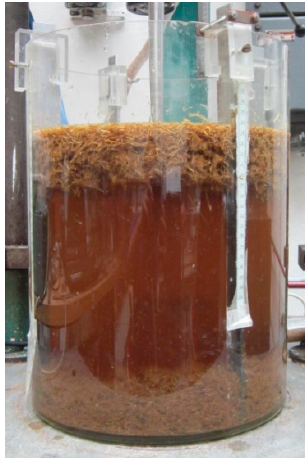
Figure 16. Example of substrate in an agitated fermenter in biogas production.